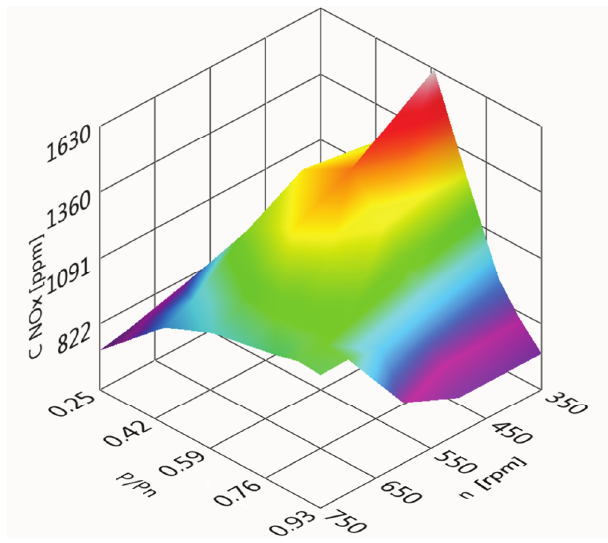
Fig. 4. Concentration NO x